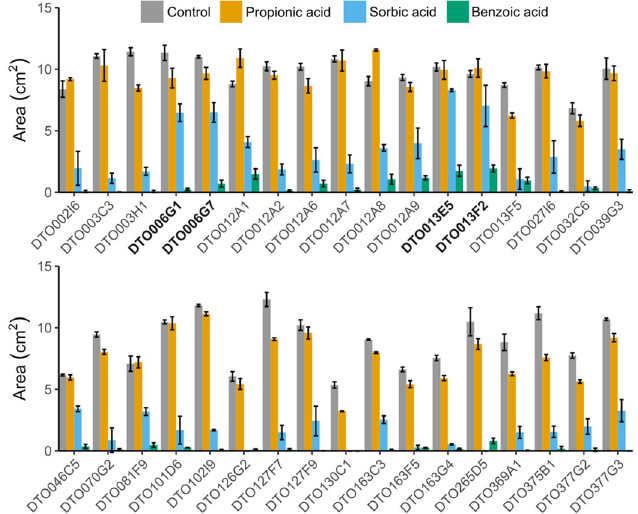
Fig 1. Weak-acid screening shows variabe resistances to multiple acids. Average colony size (cm 2 ) of 34 P . roqueforti strains after five days of growth on MEA (pH 4.0) (grey) or MEA (pH 4.0) supplemented with 5 mM propionic acid (orange), sorbic acid (blue) or benzoic acid (green). Strains DTO006G1, DTO006G7, DTO013E5 and DTO013F2 (indicated in bold) are relatively resistant to sorbic acid. Error bars indicate standard deviation of biologically independent replicates.